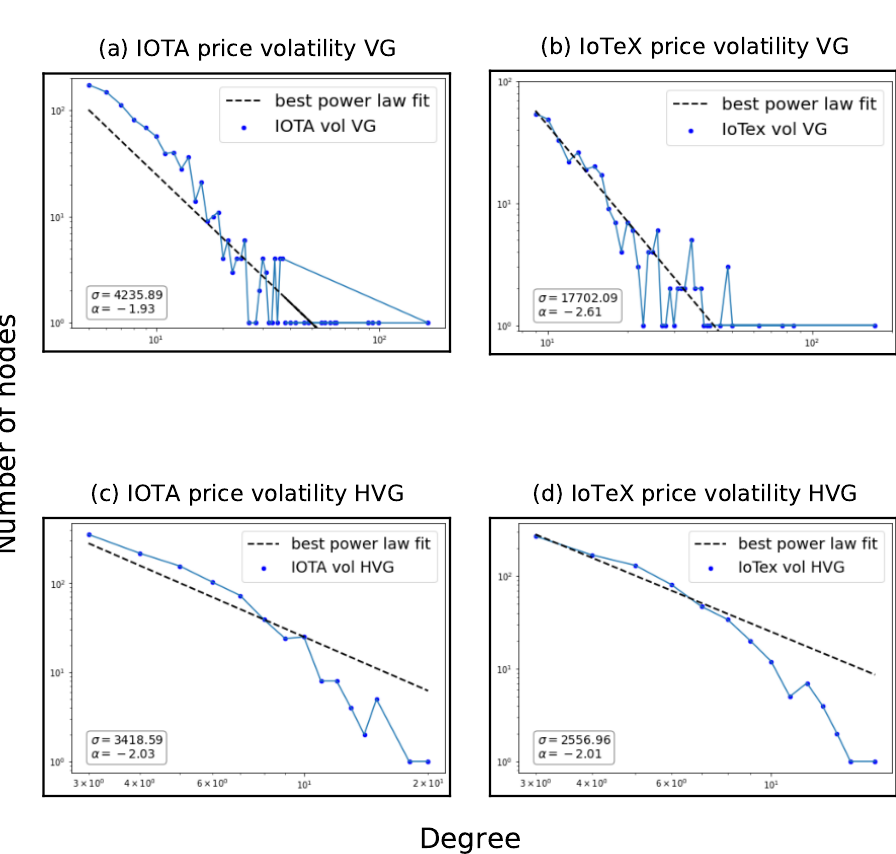
Figure 3. Number of nodes for each degree in the networks stemming from the visibility and horizontal visibility graphs for IOTA and IoTeX price volatility. Subplots ( a , b ) display the degree of the network stemming from the visibility graph and the best power law fit that the function curve_fit provides together with the corresponding best α and σ . Subplots ( c , d ) display the degree of the network stemming from the horizontal visibility graph and the best power law fit that the function curve_fit provides and the corresponding best α and σ